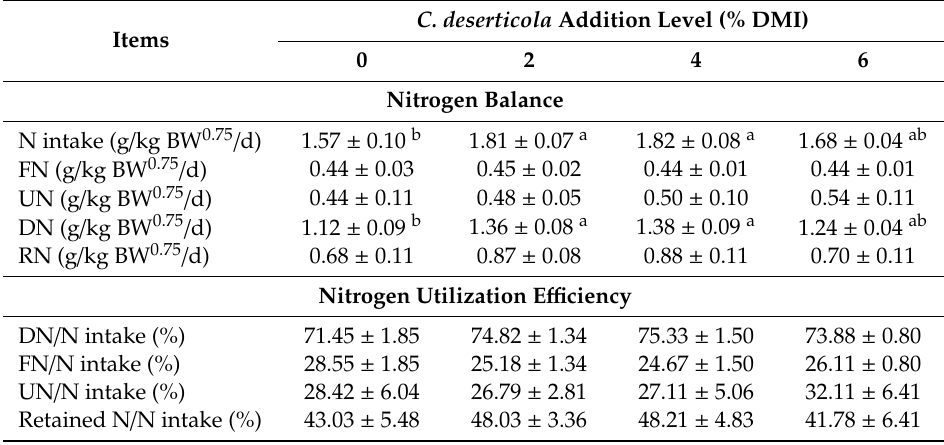
Table 4. E ff ect of C. deserticola addition on nitrogen balance and nitrogen utilization e ffi ciency (mean ±